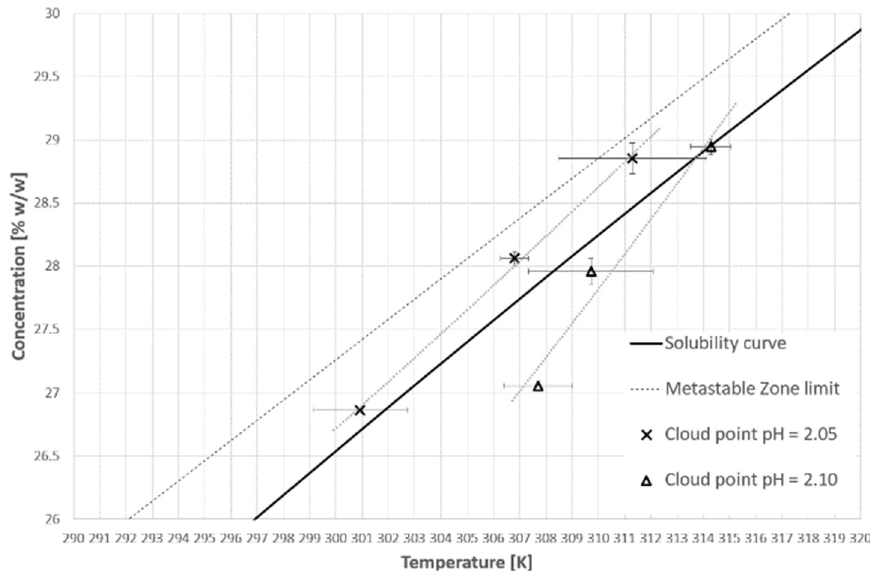
Figure 6. Cloud point temperatures for the second cooling cycle.